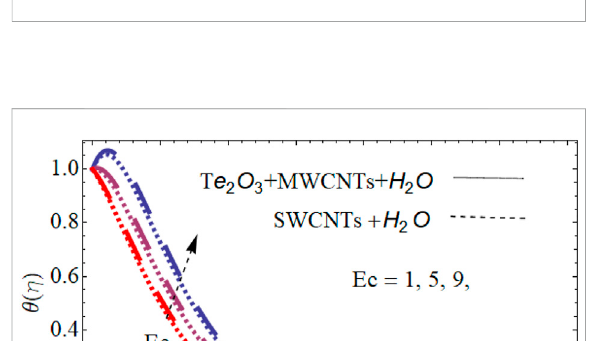
FIGURE 7 Inspiration of the solar radiation parameter on the temperature pro fi le.